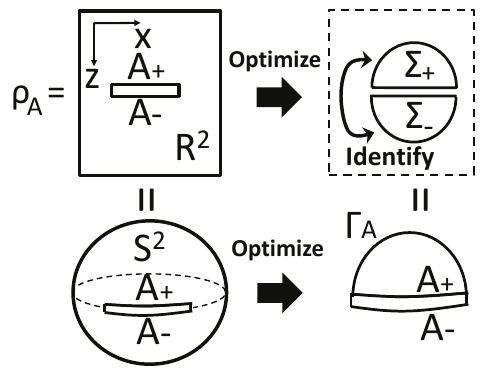
Figure 6 . The optimization of path-integral for a reduced density matrix. The upper left picture is the de(cid:12)nition of (cid:26) A in terms of the path-integral in (cid:13)at space. This is conformally mapped into a sphere with a open cut depicted in the lower left picture. The upper right one is the one after the optimization and is equivalent to a geometry which is obtained by pasting two identical entanglement wedges along the geodesic (=the half circle) as shown in the lower right picture. orbifold CFTs and can heuristically argue that R is proportional to the central charge AdS c . This is deeply connected to the fact that we (cid:12)nd the sub AdS scale locality in gravity duals of holographic